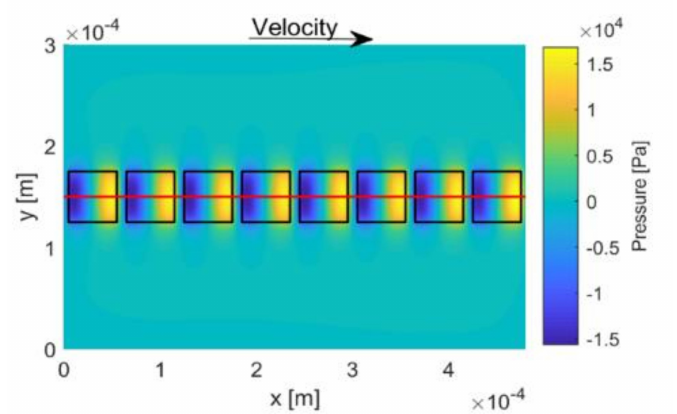
Figure 11. Pressure contour of the full texturing configuration. Square dimples with side 50 µ m and depth 10 µ m. Gap 10 µ m, sliding velocity 5 m / s.